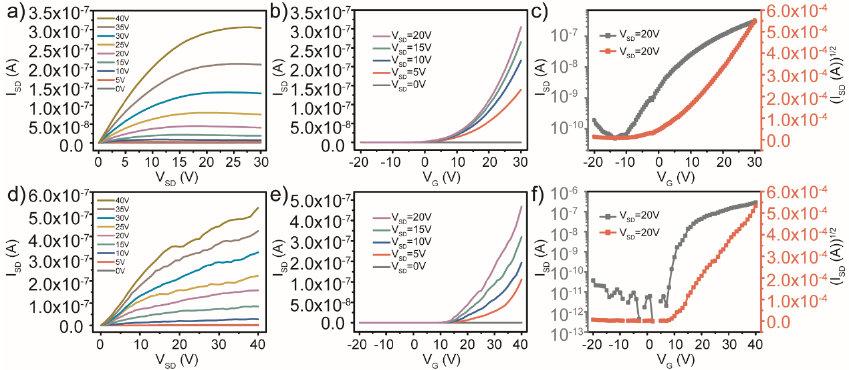
Figure 3. Output characteristics and transfer characteristics of TFTs with AZO single ‐ active ‐ layer ( a − c ) and with ZnO single ‐ active ‐ layer ( d − f ).